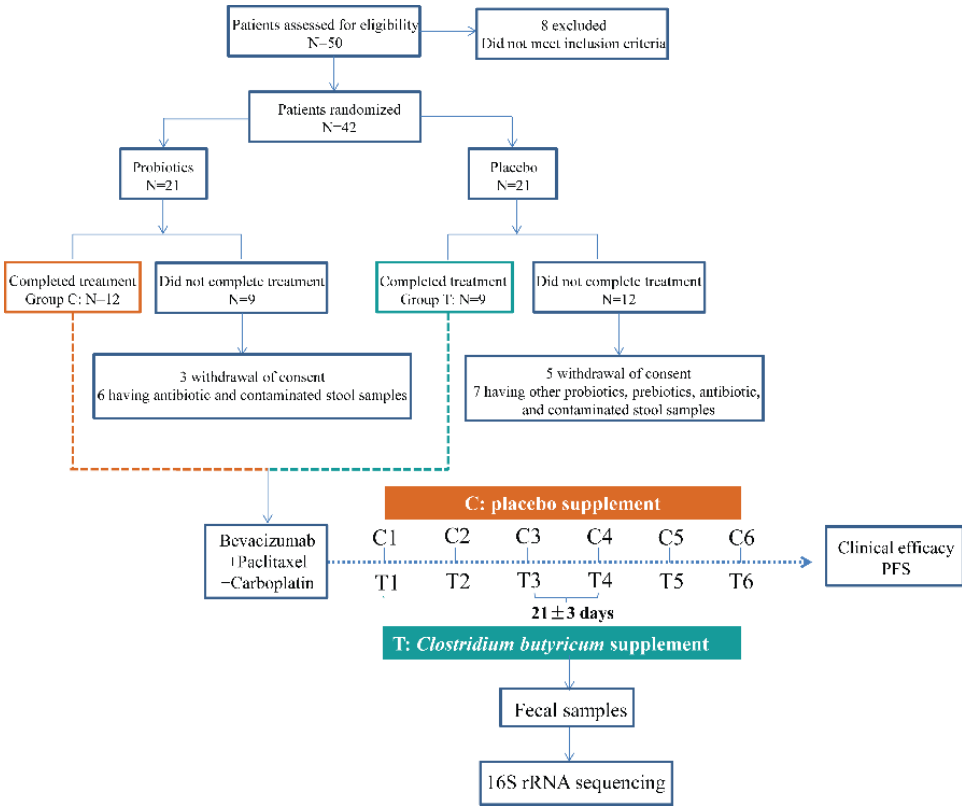
Figure 1. Study design. Twenty-one non-squamous non-small cell lung cancer (NS-NSCLC) patients were recruited for the cohort study. Fecal samples from these NS-NSCLC patients with placebo and Clostridium butyricum supplement (group C and T) were collected prior to each treatment. Table 1. Clinical characteristic of 21 NS-NSCLC patients.